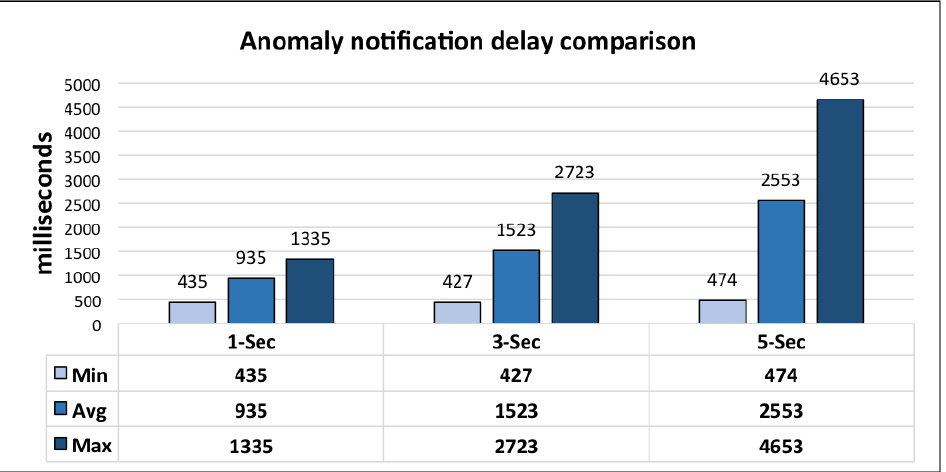
Figure 17. LLM performance